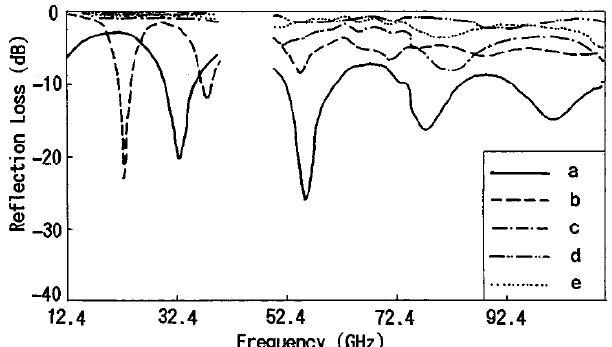
Figure 19. Reflection loss of different carbon materials (3 wt%) in polyurethane: ( a ) CMCs; ( b ) straight vapor grown carbon fibers and ( c – e ) different types of carbon powders [10]. Reprinted with permission from [10], Copyright 2003 AIP Publishing